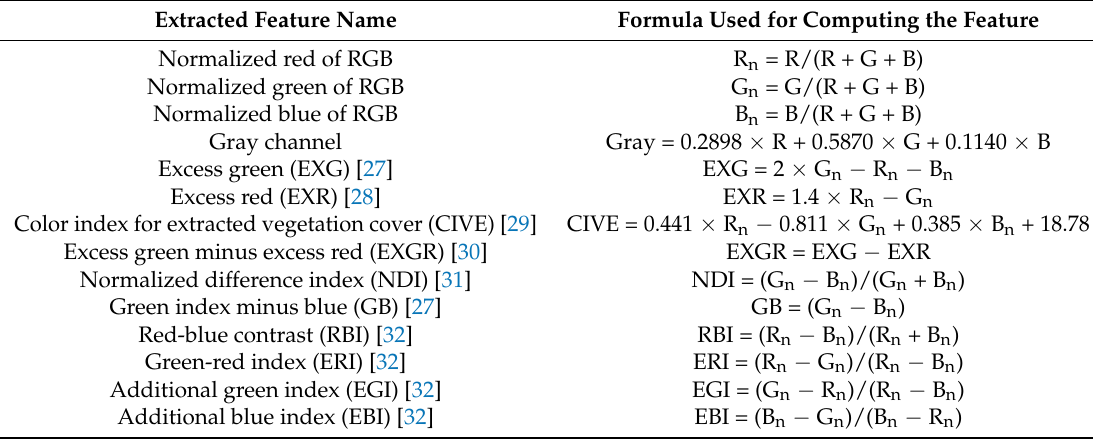
Table 2. Color features extracted for each object as vegetation